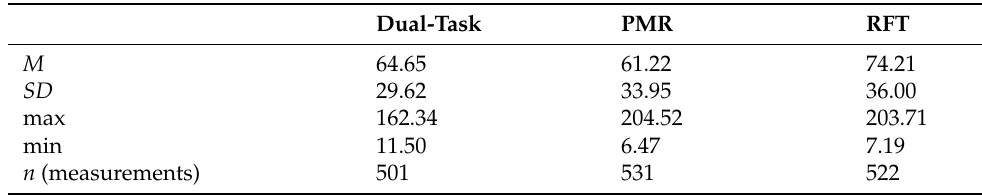
Table 1. Descriptive statistics of raw